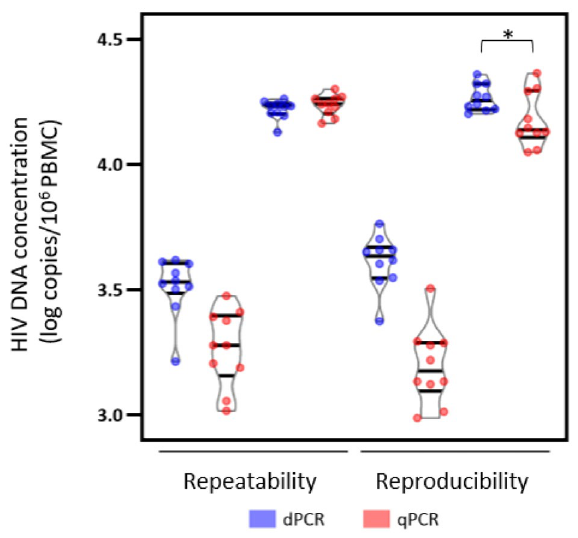
Figure 3. Precision experiments to compare the dPCR and qPCR methods with the coefficient of variation (CV%). The data of the repeatability and reproducibility studies for the two concentrations (100 and 1000 copies/10 6 PBMC) are represented in log-transformed data in a violin plot. The violin plot shows median values and 25% and 75% interquartile ranges of the CT and 5% and 95% ranges. The non-parametric test (Siegel- Tukey) shows that the CV% of the reproducibility at 1000 copies/10 6 PBMC is significatively different between the dPCR and qPCR with a p-value =